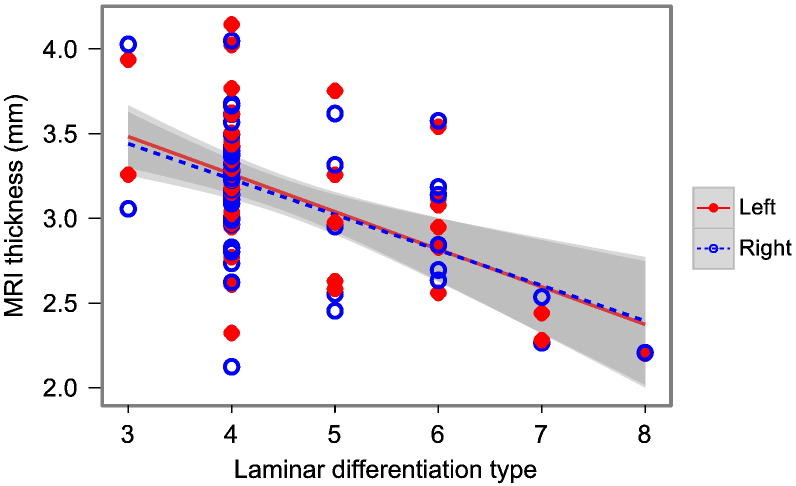
Macaque cortical thickness and cytoarchitecture. MRI thickness—corrected for folding—against laminar differentiation type (rs = − 0.39, p < 0.001). Laminar differentiation type is a cytoarchitectural ranking scale, with 6-layered primary sensory cortex having type 8, while less well differentiated cortical regions are given progressively lower rankings (Barbas, 1986; Barbas and Rempel-Clower, 1997; Dombrowski et al., 2001).